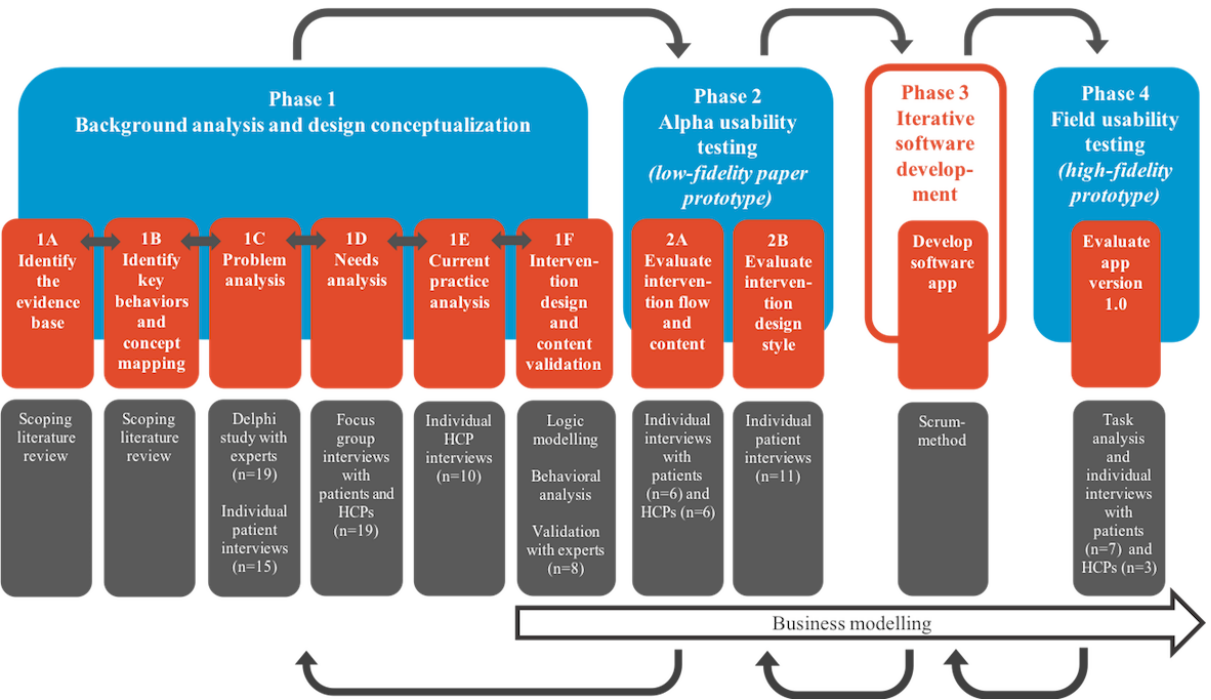
Figure 1. User-centered design for the development of the mobile health intervention. HCP: health care